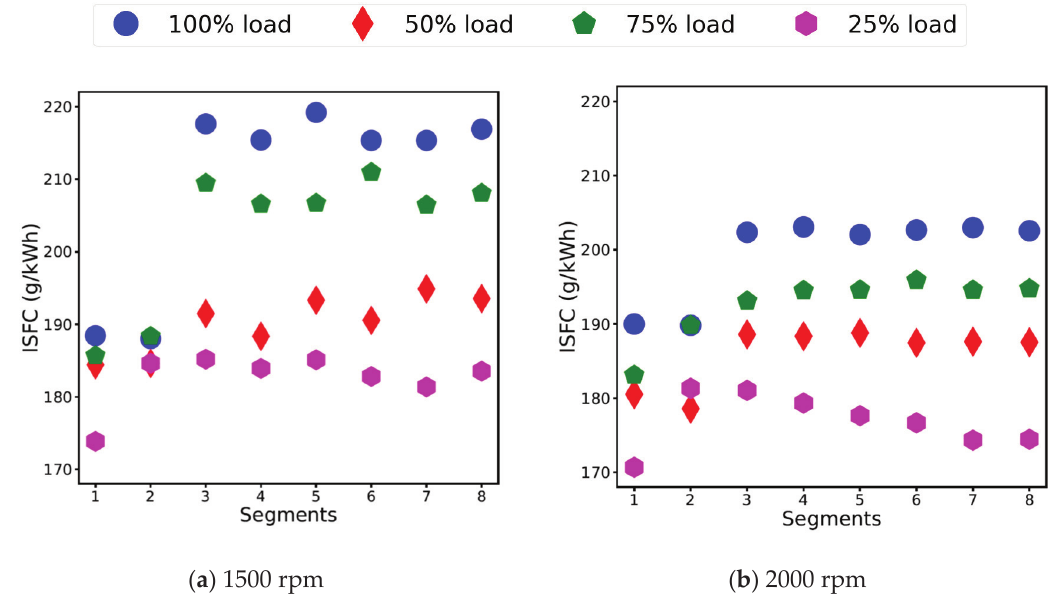
Figure 10. Indicated specific fuel consumption (ISFC) at each load in each segment at ( a ) 1500 and ( b ) 2000 rpm. The blue circle represents 100% load, the red diamond 50% load, the green pentagon 75% load and the pink hexagon 25% load.